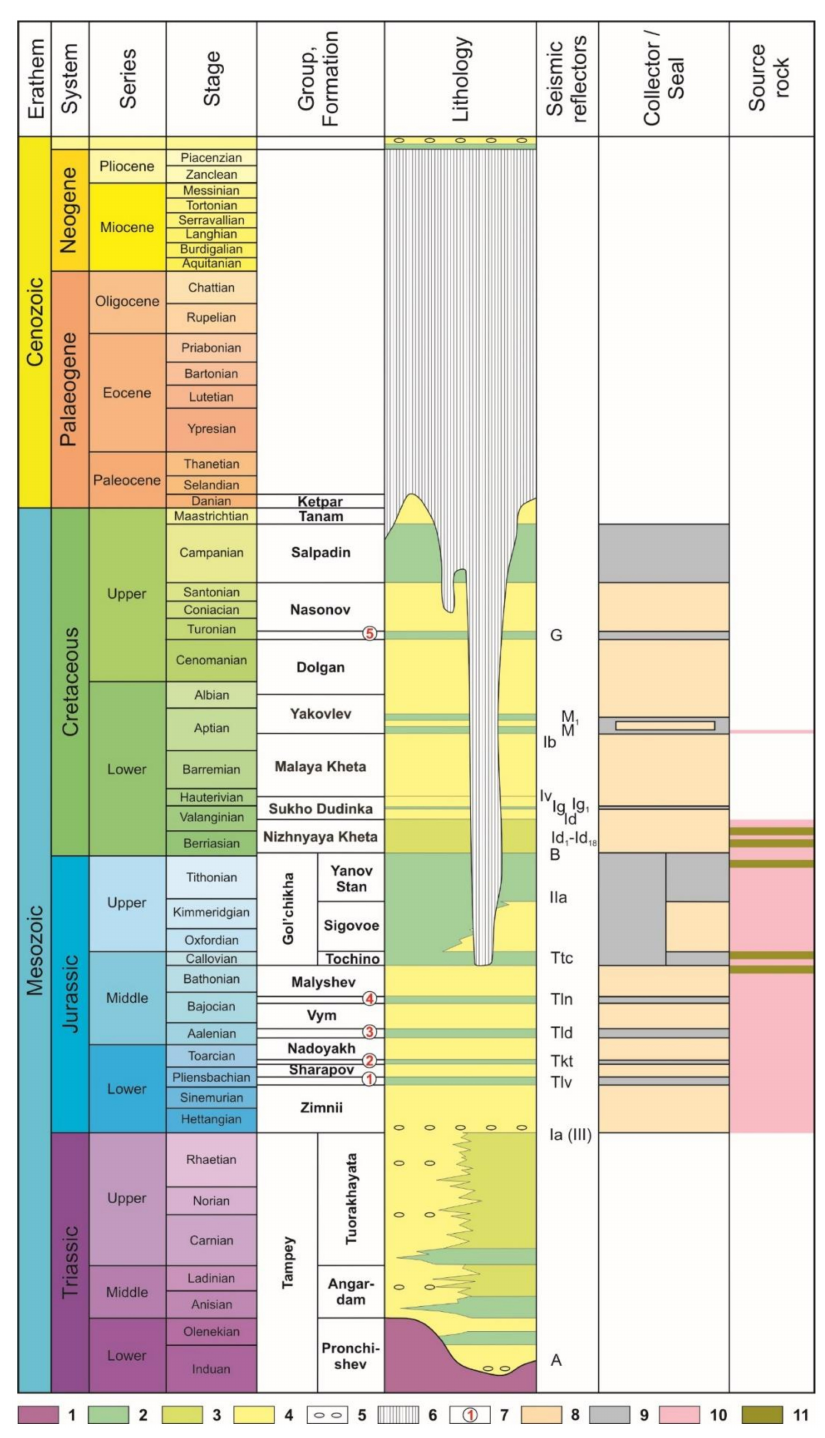
Figure 11. Lithostratigraphic scale of the Yenisei-Khatanga basin’s sedimentary fill.